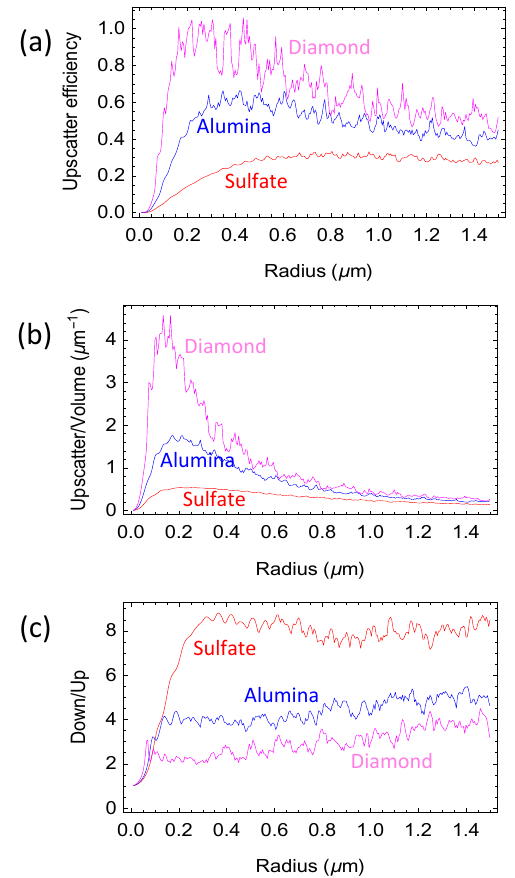
Figure 6. Comparison of radiative scattering properties of alumina and diamond monomers and sulfate aerosol particles as functions of particle radius. Panel (a) shows the upscatter efficiency which is the upscatter cross section divided by the geometric cross section (a dimensionless ratio). Panel (b) shows the upscatter cross section divided by the particle volume (units ofµm − 1 ) , and panel (c) shows the ratio of downscatter cross section to upscatter cross section in- tegrated over the solar